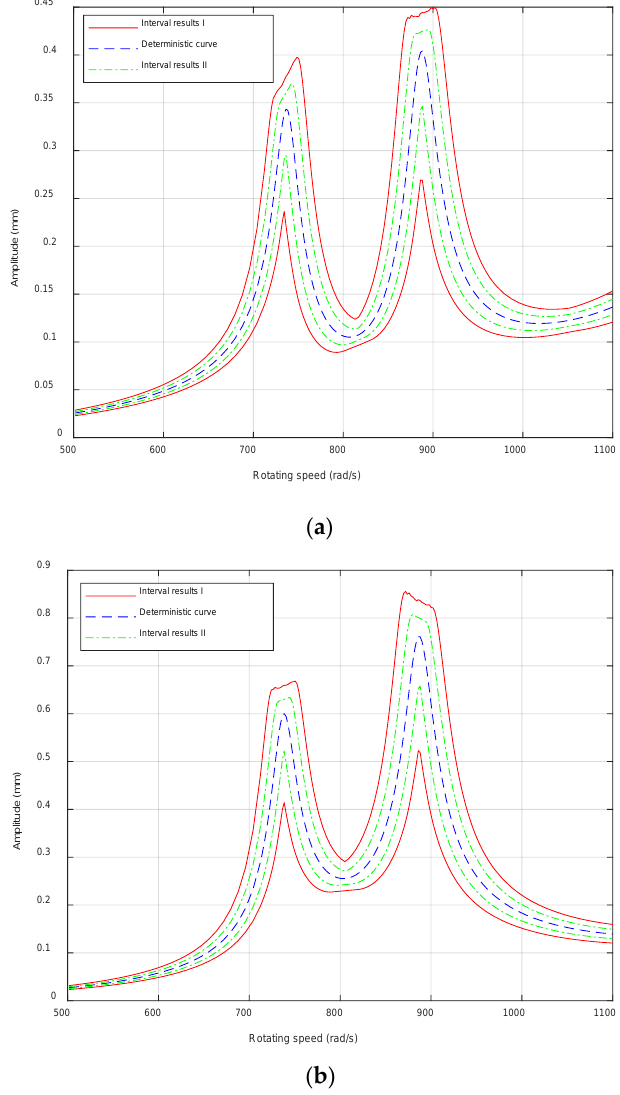
Figure 8. Dynamic responses of the dual-rotor with multi uncertain parameters: ( a ) Interval responses of the HP rotor; ( b ) Interval responses of the LP rotor.